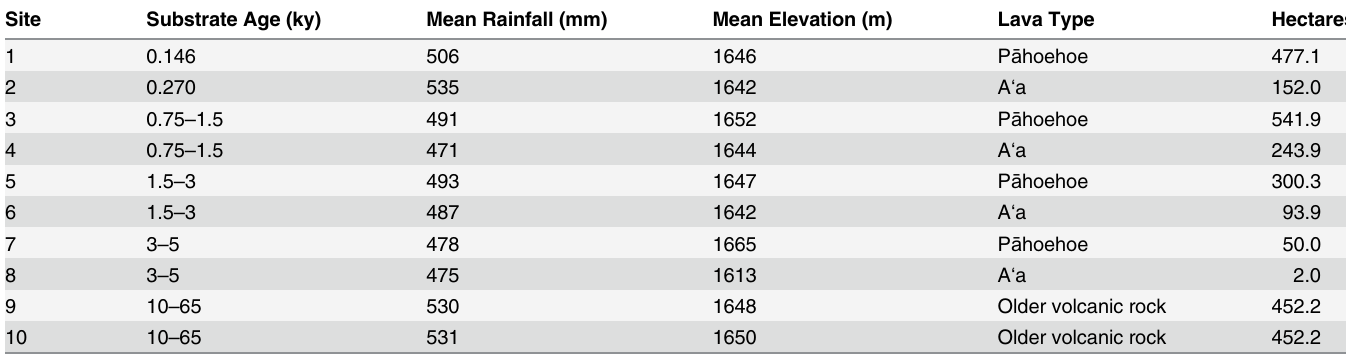
Table 1. Site characteristics of the P ō hakuloa substrate age